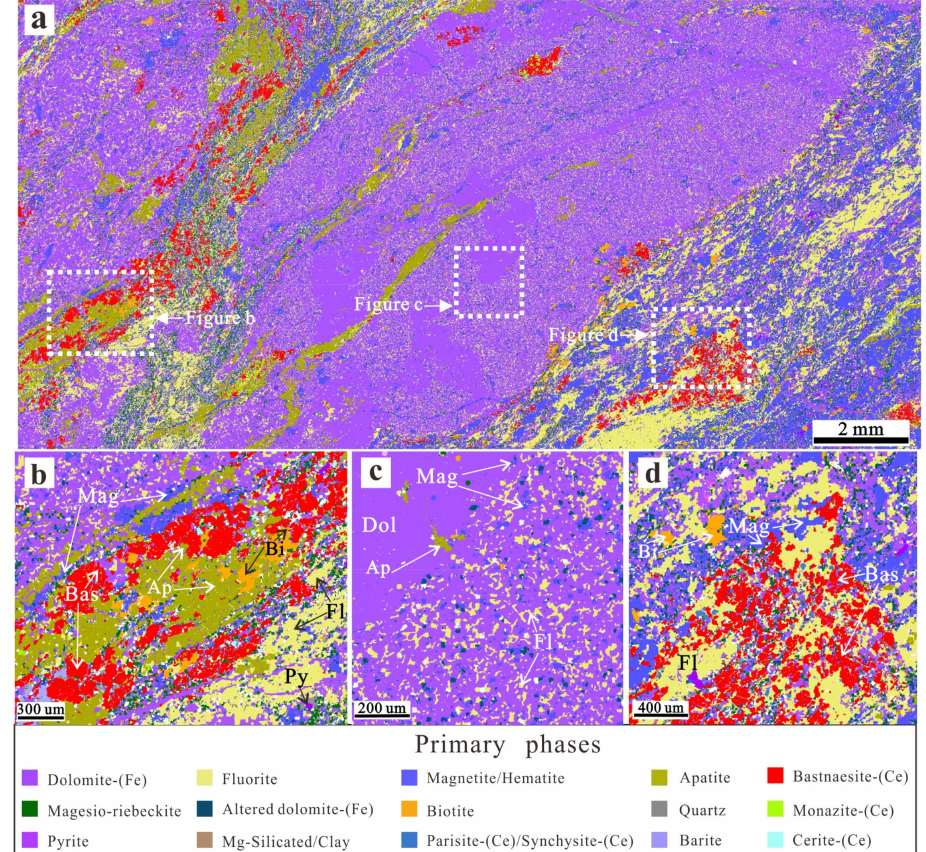
Figure 7. The TIMA false-colored mineral phase map of the 1406 m drill ore sample. ( a ) the whole image of the thin section shows deformed banded ore texture; ( b ) the bastnäsite-(Ce) intergrowth with apatite, fluorite, magnetite, and biotite, forming complex veins overprinted on the dolomite-(Fe); ( c ) the dolomite-(Fe) matrix has been altered and overprinted by tiny and disseminated mineral aggregates composed of magnetite and fluorite; ( d ) the bastnäsite-(Ce) intergrowth with fluorite, magnetite, and biotite but without apatite. Abbreviations: Dol, dolomite-(Fe); Bas, bastnäsite-(Ce); Fl, fluorite; Mag, magnetite; Ap, apatite; Py, pyrite; Bi,